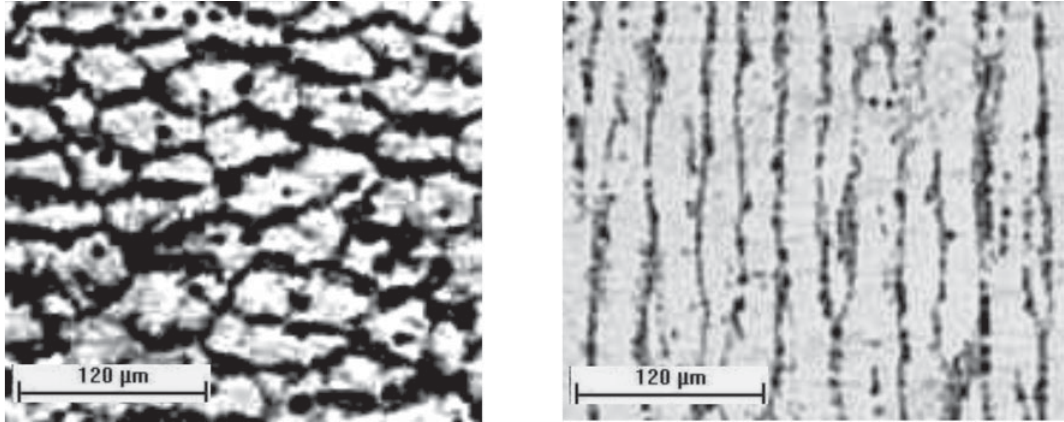
Figure 8. Cellular microstructure for Sn-1.5wt%Pb alloy (P = 10 mm, λ